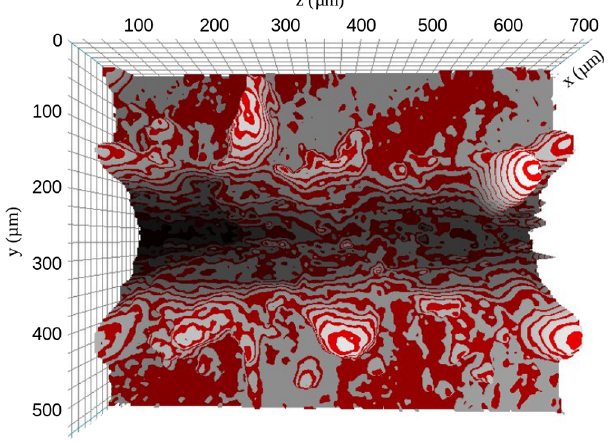
m.FIG. 26. Anamorphic topological map of beam strike SN 08, 202 mA from the same 700 μ m-length section of the top collimator shown in Fig. 25. The increment in the x direction is 2 μ m. SN08, z 0 location is presented in Fig. 26. Each contour line represents a spacing of 2 μ m.